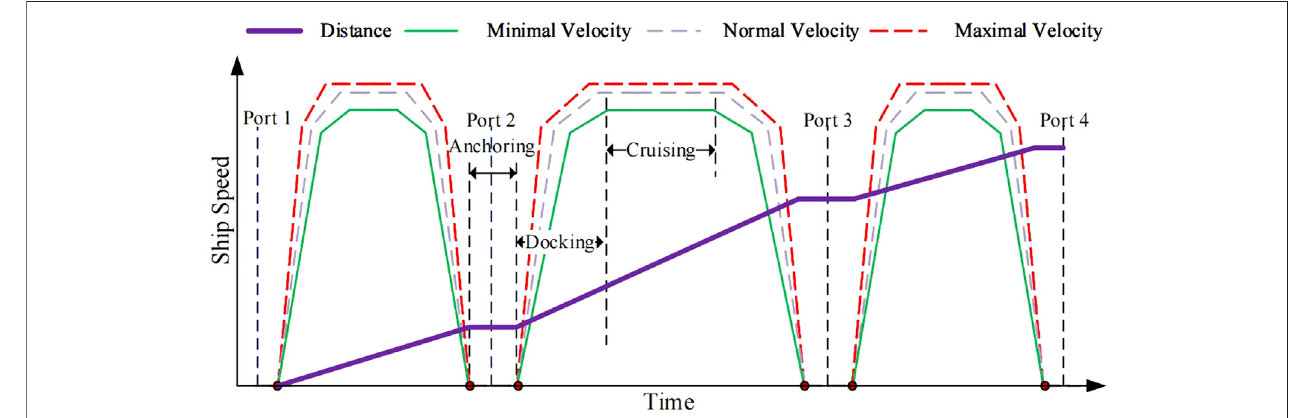
FIGURE 2 | Typical cross section of a sailing voyage with velocity